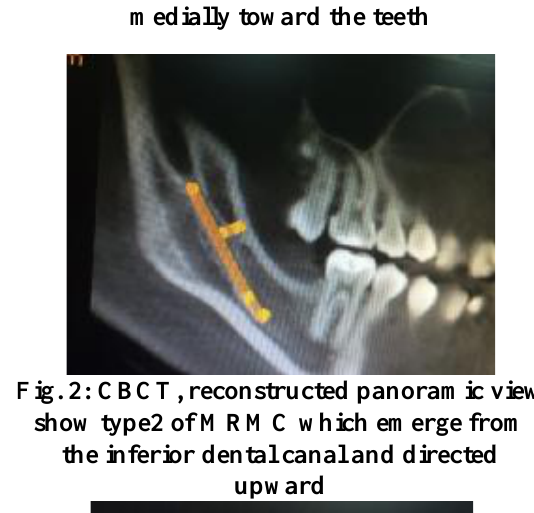
Fig. 1: CBCT, reconstructed panoramic view show type3 of MRMC which emerge from the inferior dental canal and directed medially toward the teeth